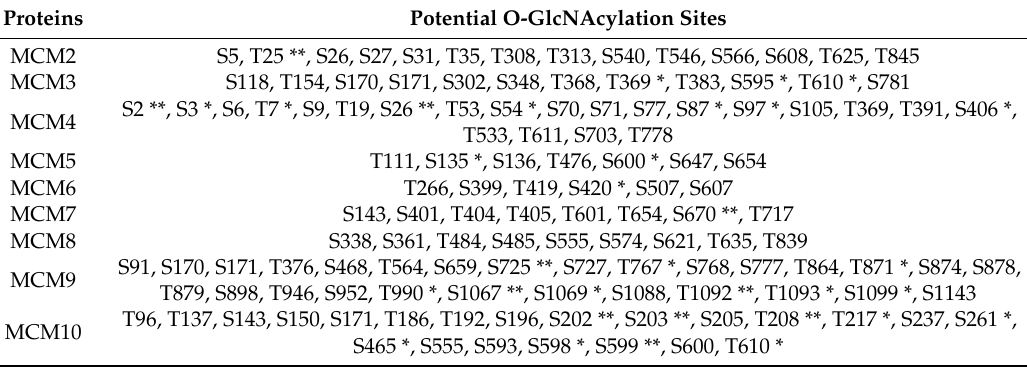
Table 6. Predicted O -N-acetyl-D-glucosamine (GlcNAc)ylation sites for MCMs.